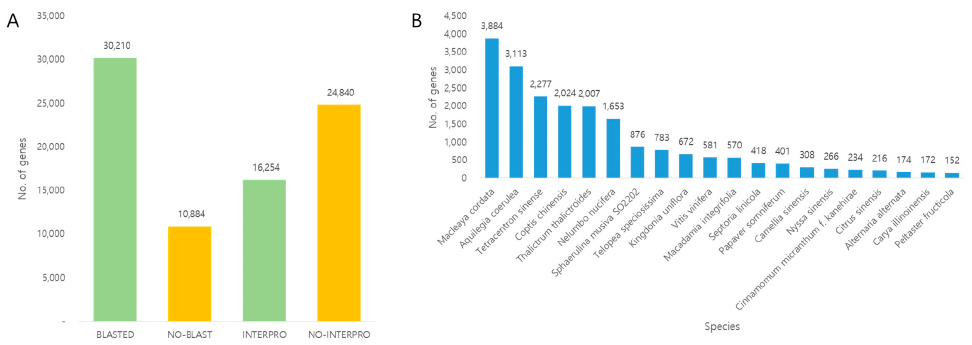
Figure 2. ( A ) Mapping of the transcripts to different protein databases. ( B ) List of species matching the C. robustum transcriptomes to other transcriptomes.